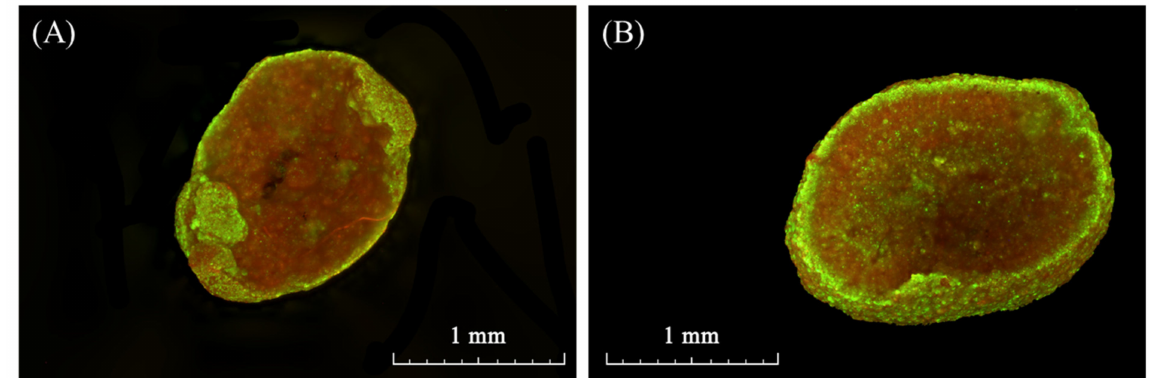
Figure 6. Live/dead stained cross-section of 1.1 mm ( A ) and 1.8 mm ( B ) nitrifying granules after 305 days of cultivation in the GMBR.